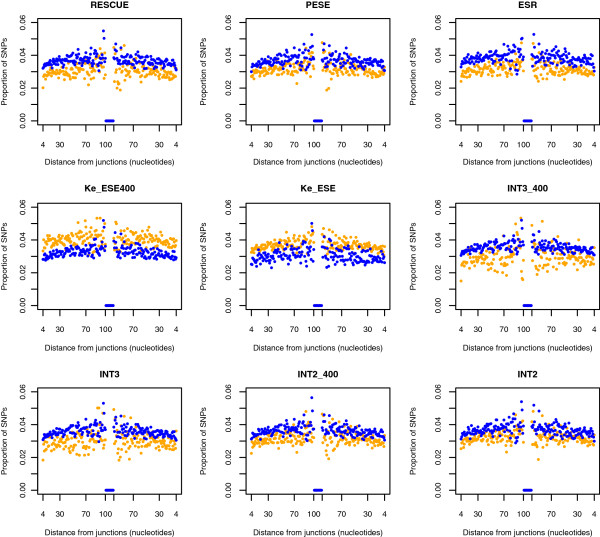
SNP density in and out of ESEs as a function of the distance from the exon boundanry. ESE data is in orange, non-ESE data in blue.